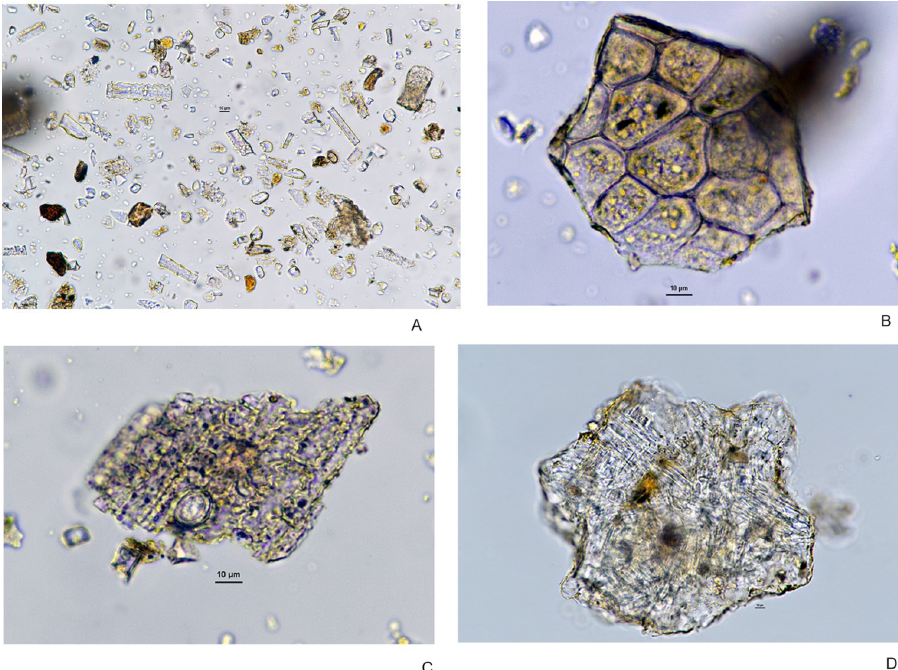
Fig 9. Examples of Zaraa Uul phytoliths: (A) Poaceae shoots and leaves, (B) dicot leaf, (C) Cyperaceae stem, (D) succulent.